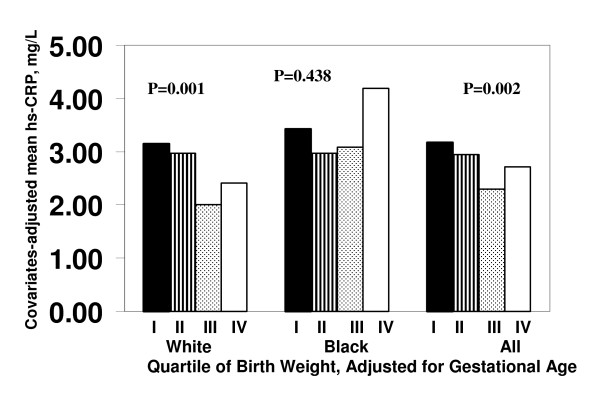
Covariates-adjusted mean values of hs-CRP by race and sex-specific quartiles of gestational age-adjusted birth weight: The Bogalusa Heart Study. Quartile I represents the lowest birth weight, and quartile IV represents the highest birth weight. Covariates included race (for the total sample), sex, age, body mass index and smoking status.